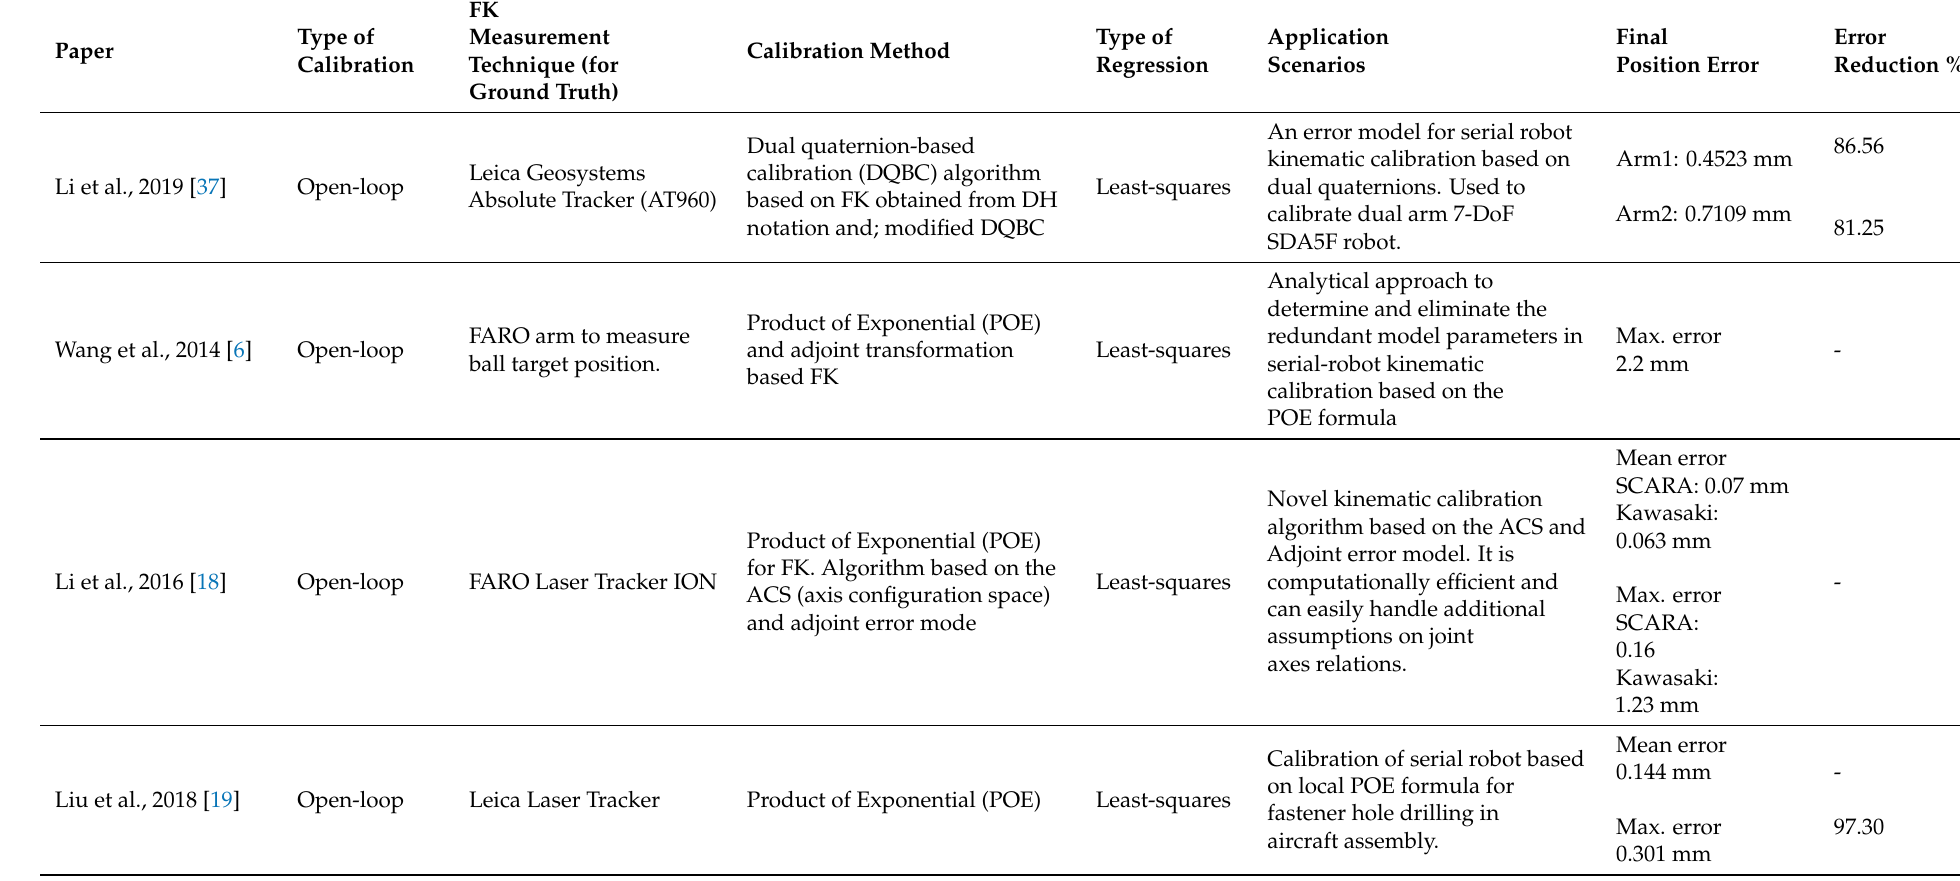
Table 1. Brief comparison of kinematic calibration